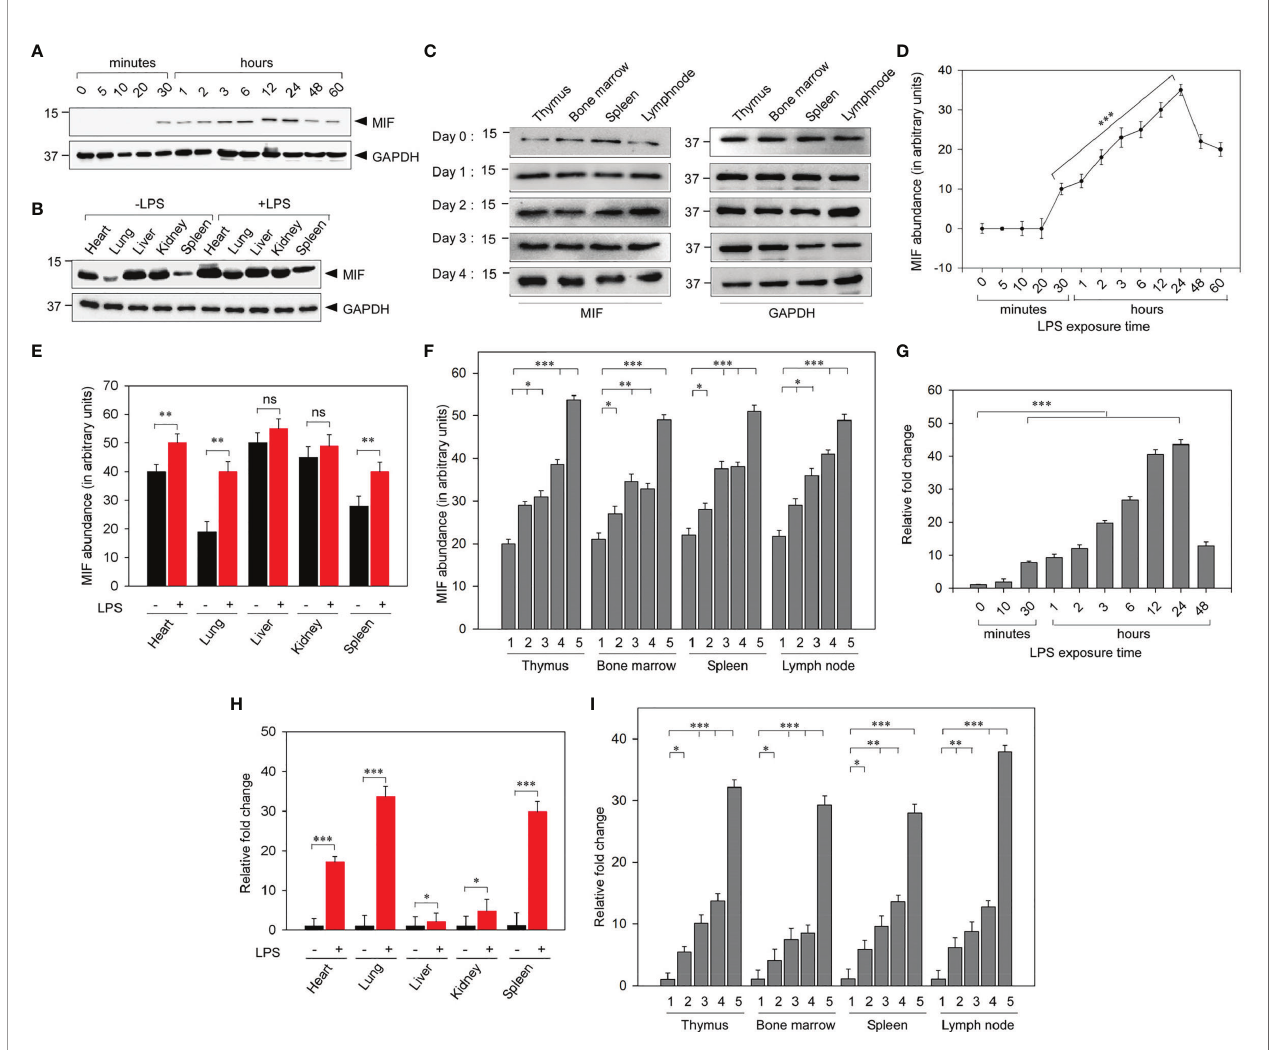
FIGURE 3 | Analysis of the macrophage migration inhibitory factor (MIF) pro fi le in leptospiral lipopolysaccharide (LPS)-induced experimental models. (A) Representative Western blot analysis of the increased expression of MIF in LPS-treated THP-1 cells in a time-dependent manner. (B) Representative Western blot analysis of the signi fi cantly upregulated expression of MIF in the lungs and spleen among the vital organs of LPS-induced BALB/c mice. (C) Representative Western blot analysis of the progressive MIF upregulation in primary and secondary lymphoid organs at different time intervals. (D – F) Quanti fi cation of MIF abundance by densitometric measurement from (A – C) , respectively. (G – I) Analyses of leptospiral LPS-stimulated MIF mRNA expressions in THP-1 cells (G) and in vital organs (H) and lymphoid organs (I) of BALB/ c mice by qRT-PCR. 1 , day 0; 2 , day 1; 3 , day 2; 4 , day 3; 5 , day 4. n = 3 experiments. * p < 0.05; ** p < 0.01; *** p < 0.001. ns, no signi fi